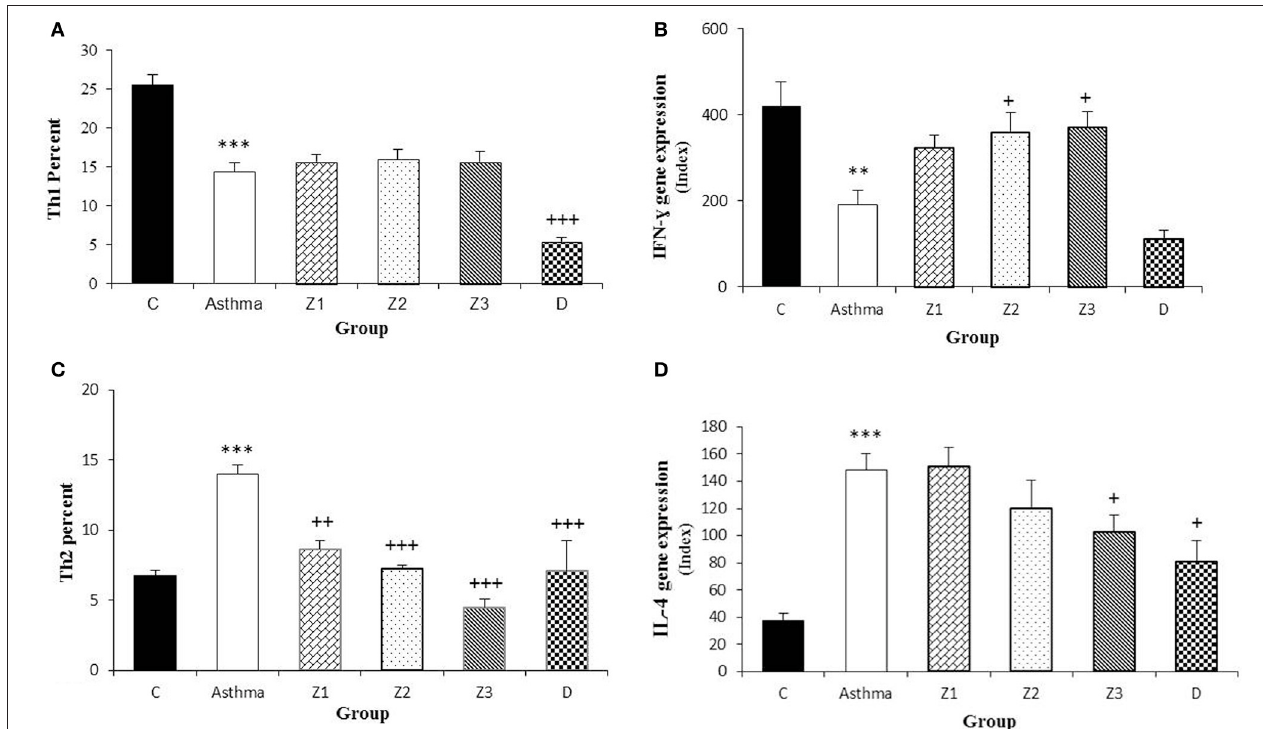
FIGURE 4 | Percent of Th 1 and Th 2 cells (A,C) and values of IFN- γ and IL-4 gene expression (B,D) in splenocyte from control group (C, n = 5), Asthma group (A, n = 5) and A treated groups with the extract of Z. multiflora at concentrations 200, 400, and 800 µ g/mL (groups Z1, Z2, and Z3, respectively, n = 6) and dexamethasone (D, n = 5). Data were presented as mean ± SEM. ** p < 0.01, *** p < 0.001, vs. control group. + p < 0.05, ++ p < 0.01, +++ p < 0.001, vs. asthma group. The statistical comparisons were made using ANOVA with Tukey–Kramer multiple post-hoc